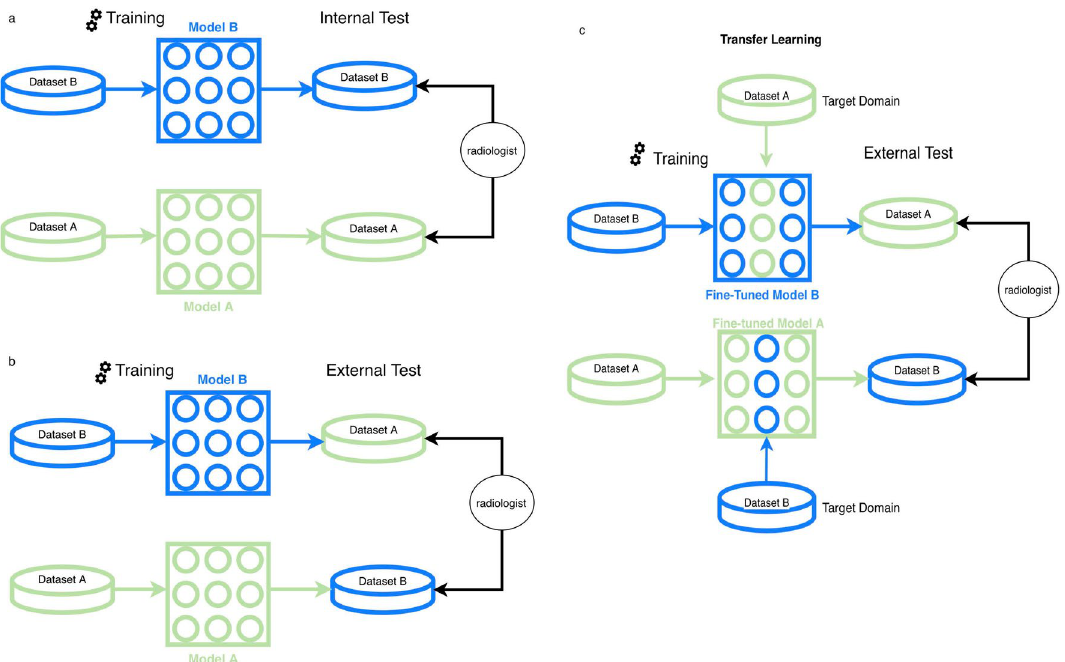
Figure 3. The flowchart of the deep learning experiments. (A) The deep learning models trained on datasets A and B were referred as models A and B. The segmentation performance of models A and B were first assessed on the internal test sets that consisted of images from the scanners of the same manufacturer. (B) Subsequently, the models’ performances were evaluated on the test partition of the other dataset, which was referred as external test. (C) The validation parts of each dataset were used to fine-tune the pre-trained model using transfer learning. These models were referred as fine-tuned models A and B, respectively. Subsequently, the fine-tuned models’ performances were assessed on the external test sets. A single expert radiologist made segmentations on the test partitions of the datasets for performance comparisons with the deep learning